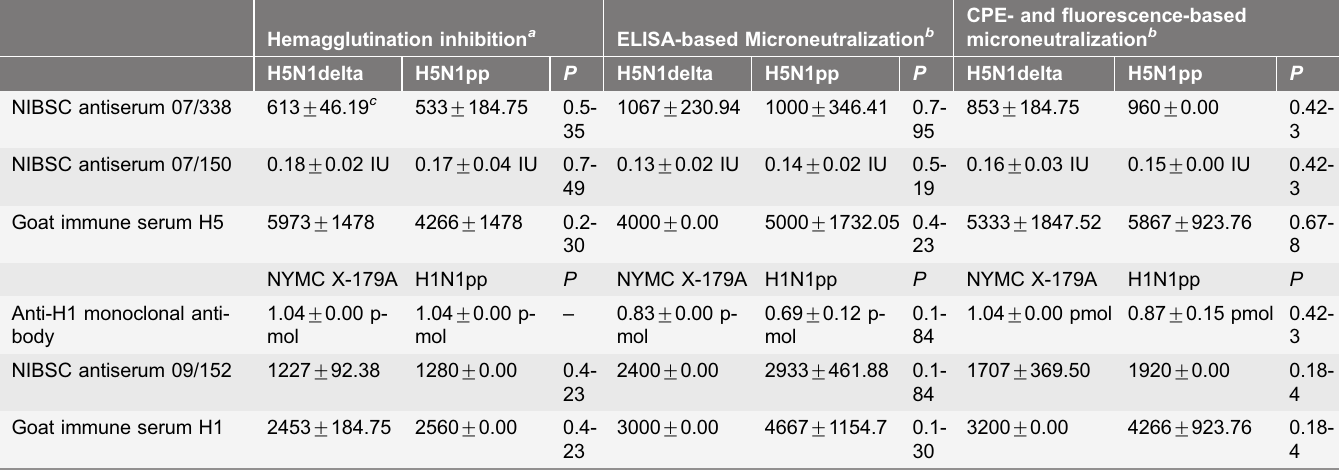
Table 1. Comparative analysis of the viruses and pp by hemagglutination inhibition testing and ELISA-, CPE-, and fluorescence-based microneutralization